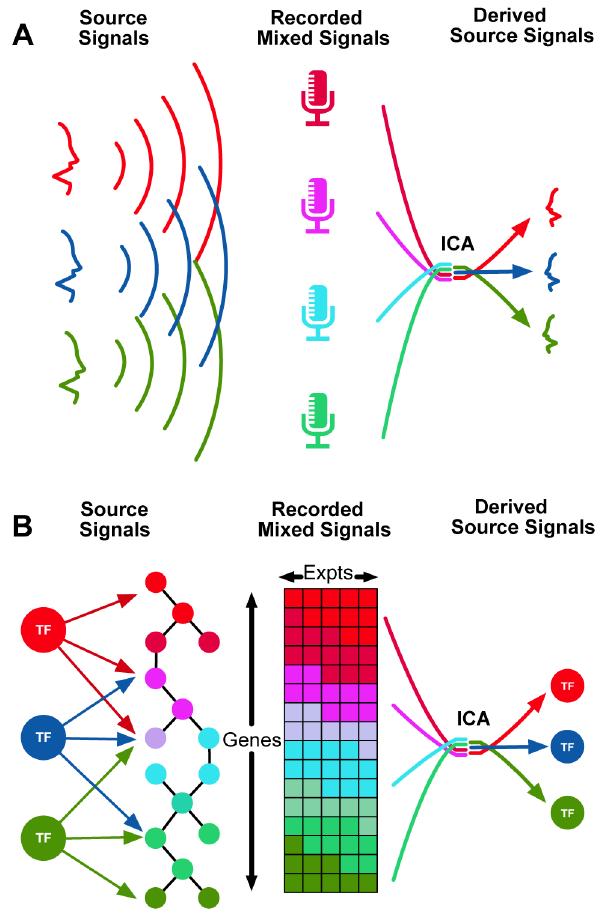
Figure 1. Independent Component Analysis (ICA) can be used to identify transcriptional modules from gene expression data. (A): The classical example of ICA is the ‘‘cocktail party problem,’’ where a number of microphones are placed in a room, capturing a mixture of conversations. Source separation methods such as ICA attempt to deconvolve the recorded mixed signals into their separate source signals (individual conversations). (B): An analogous application involves identifying source signals of transcriptional regulators from complex gene expression measurements.